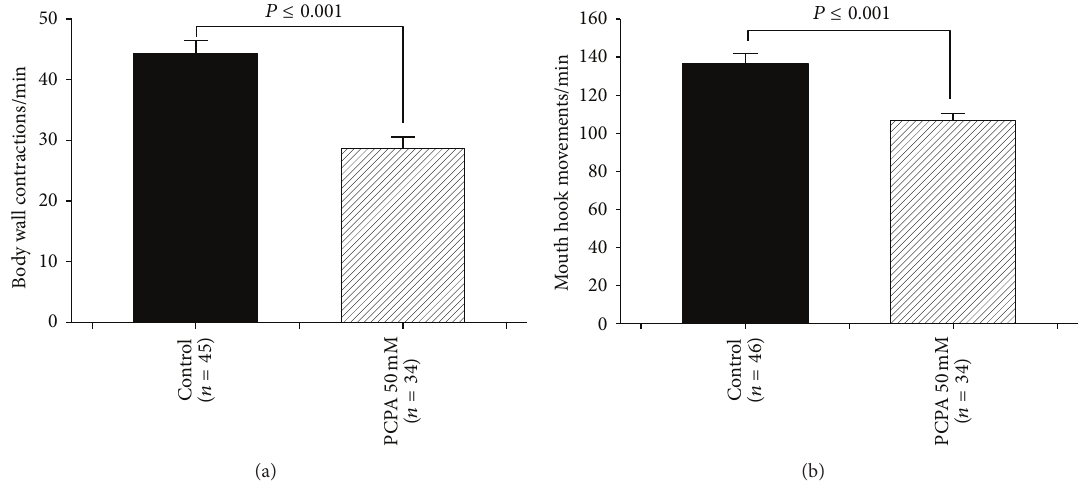
Figure 3: The behavioral consequences of blocking 5-HT synthesis. (a) Effect of tryptophan hydroxylase inhibitor, para -chlorophenylalanine (PCPA),onlocomotionbehavior.PCPAadministrationsignificantlydecreasedbodywallcontractions.(b)PCPA50 mMsignificantlyreduced feeding behavior. Student’s 𝑡 -test was performed to carry out comparison between groups. Data presented as mean ± SEM.